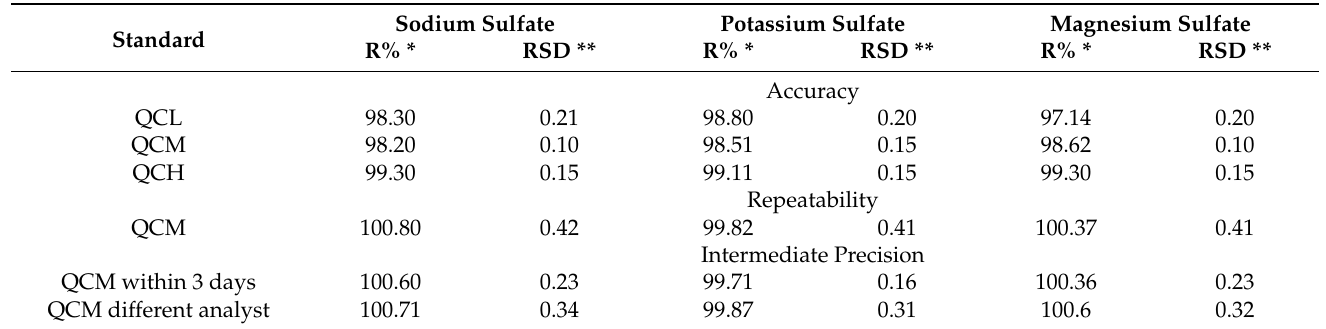
Table 2. Accuracy and precision results for determination of the analytes under study using the proposed method.